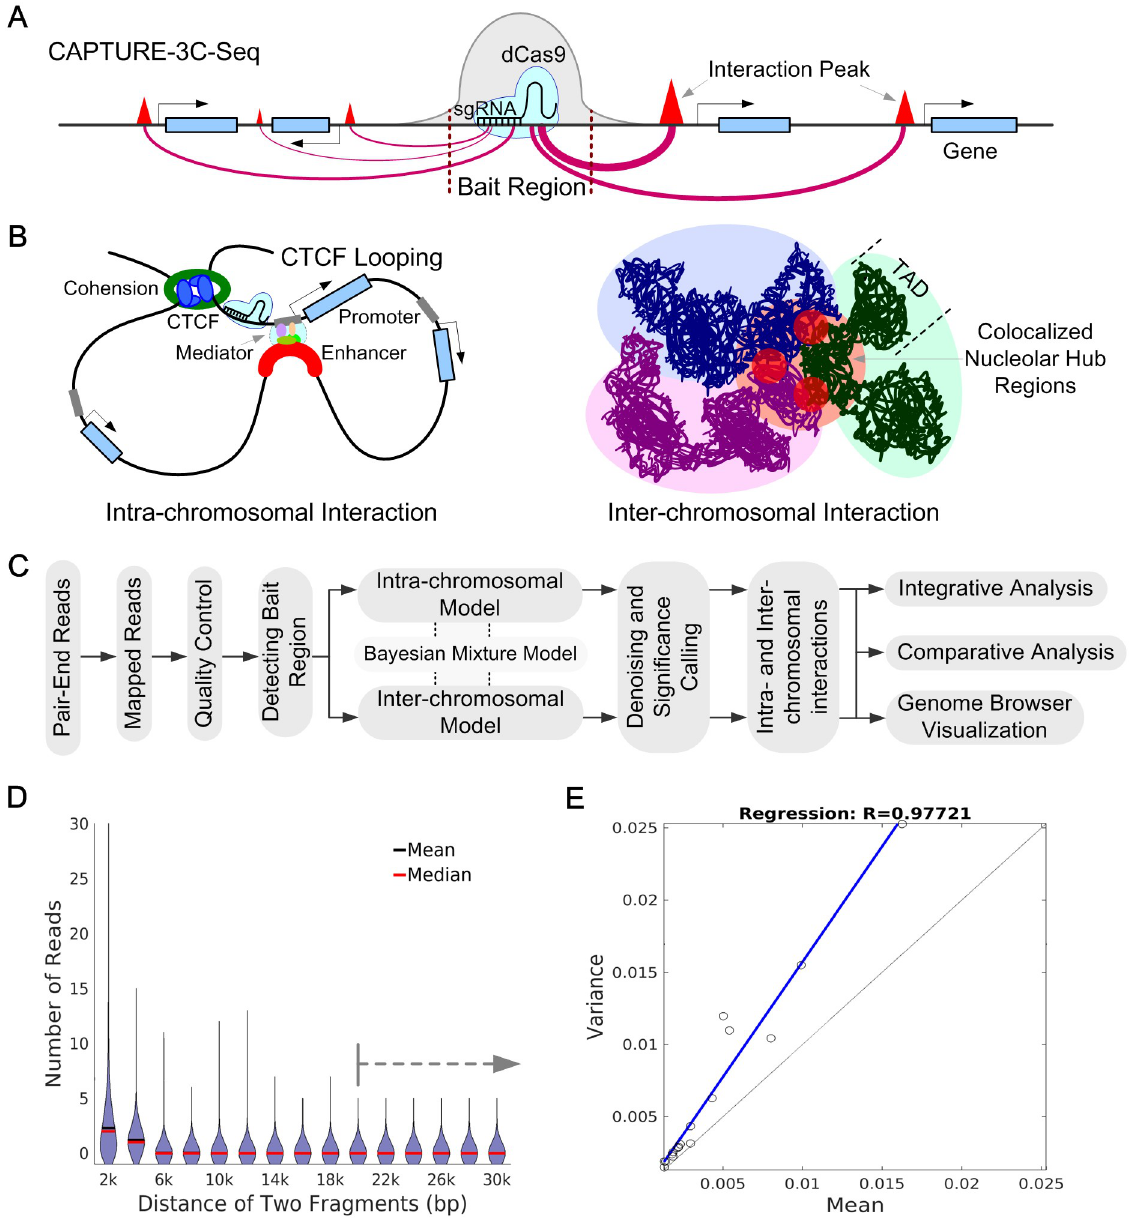
Fig 1. C3S workflow. A . A schematic of detecting chromatin interactions by CAPTURE-3C-seq. The biotinylated dCas9-based ChIP-seq was used to define the bait region. The red triangles denote the peak intensities and different red lines indicate long-range interactions associated with different significance scores. B . Two typical examples of intra- and inter-chromosomal interactions. C . The workflow of C3S pipeline. C3S takes raw reads as input and output multiple types of information for subsequent analysis. Detailed steps can be found in S1 Fig. D . Distance-based distributions are observed for random intra-chromosomal interactions. The dotted line shows that the distributions are similar after 20kb distance. E . Correlation between means and variances of distributions is shown.